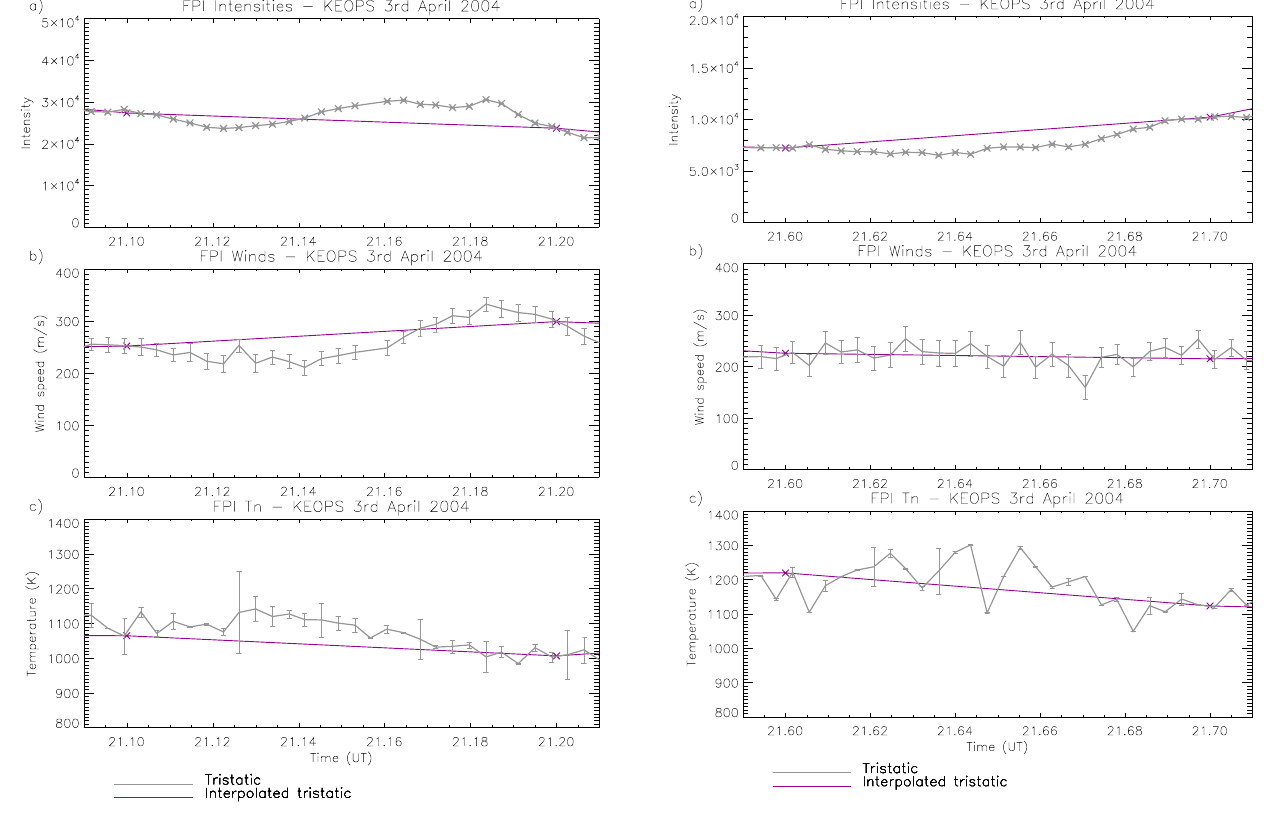
as accurate results, and noise variations are seen at this